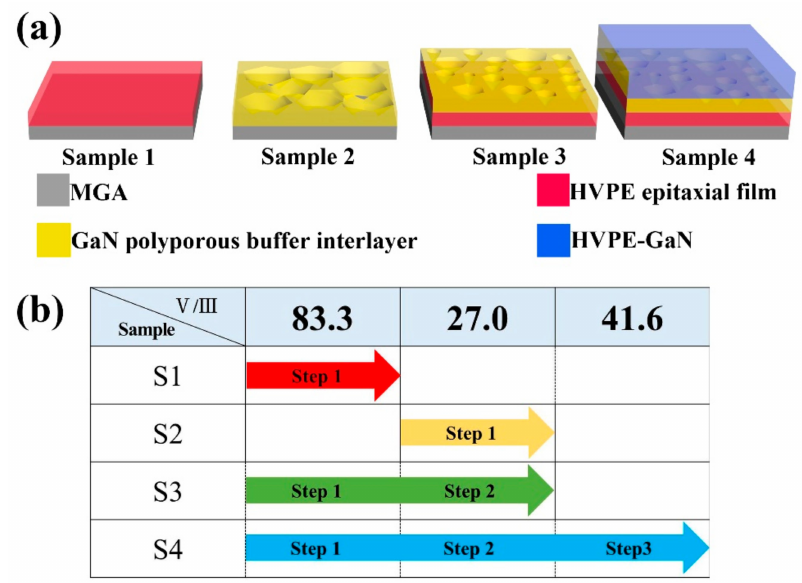
Figure 3. ( a ) Schematic diagram of high-quality GaN polyporous bu ff er interlayer formation; ( b ) Table shows the growth conditions for di ff erent